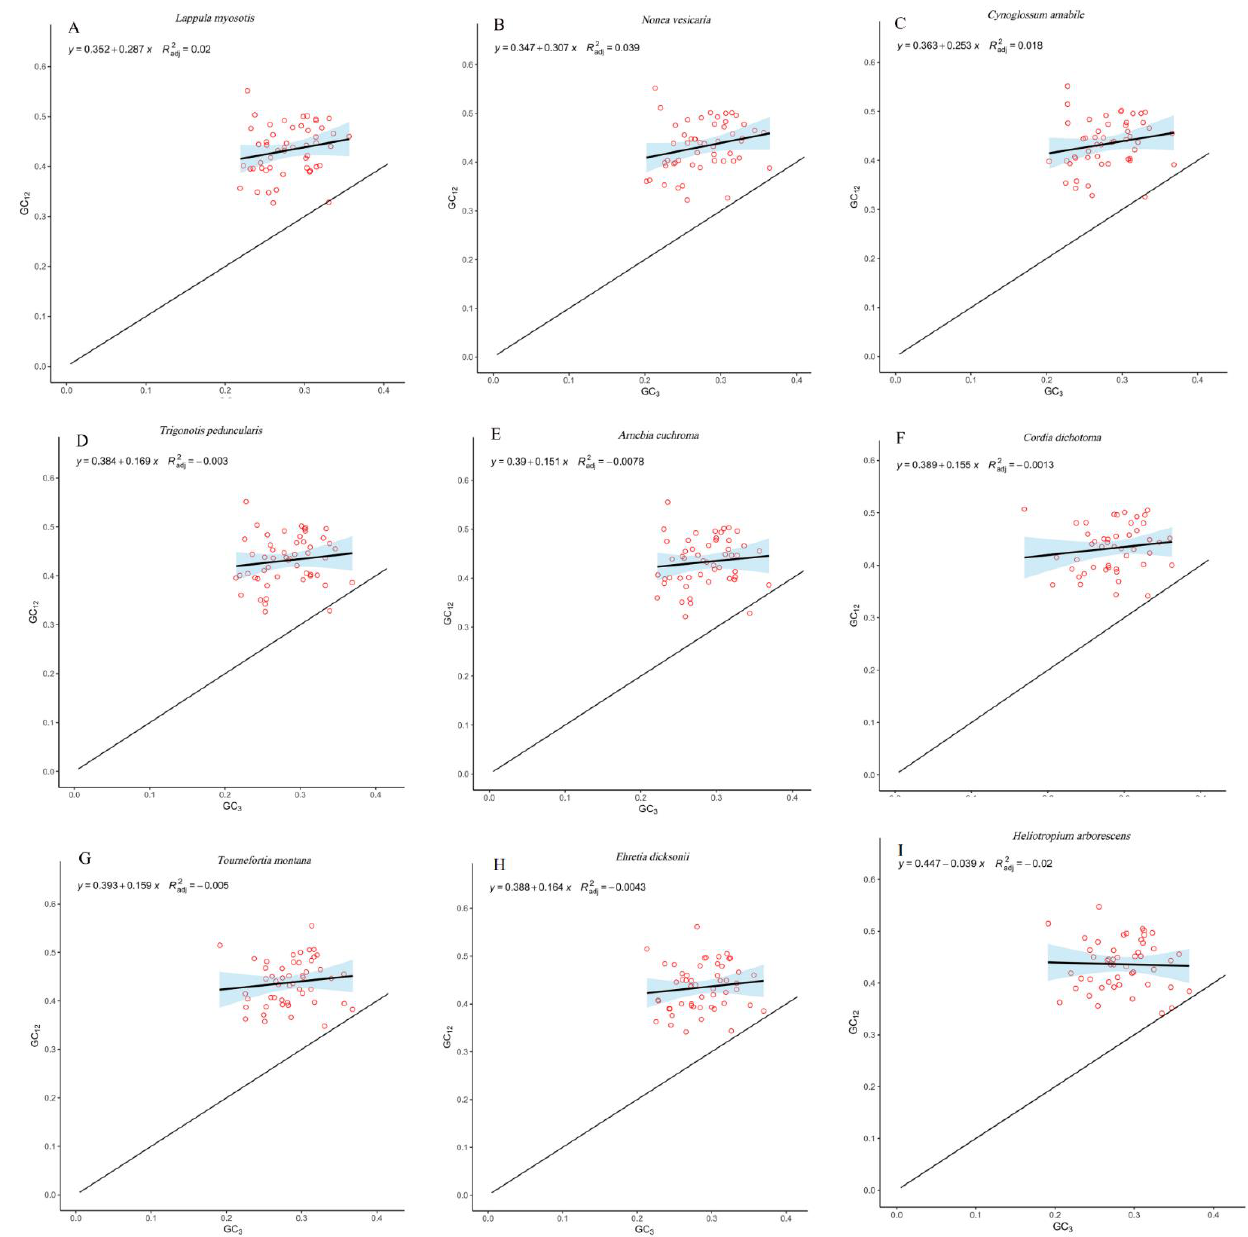
Figure 3. Neutrality plot of the nine species in Boraginales.